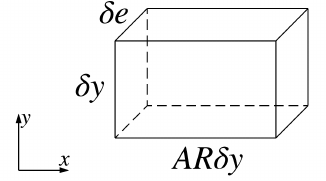
Figure 5. A typical cell in the uniform core